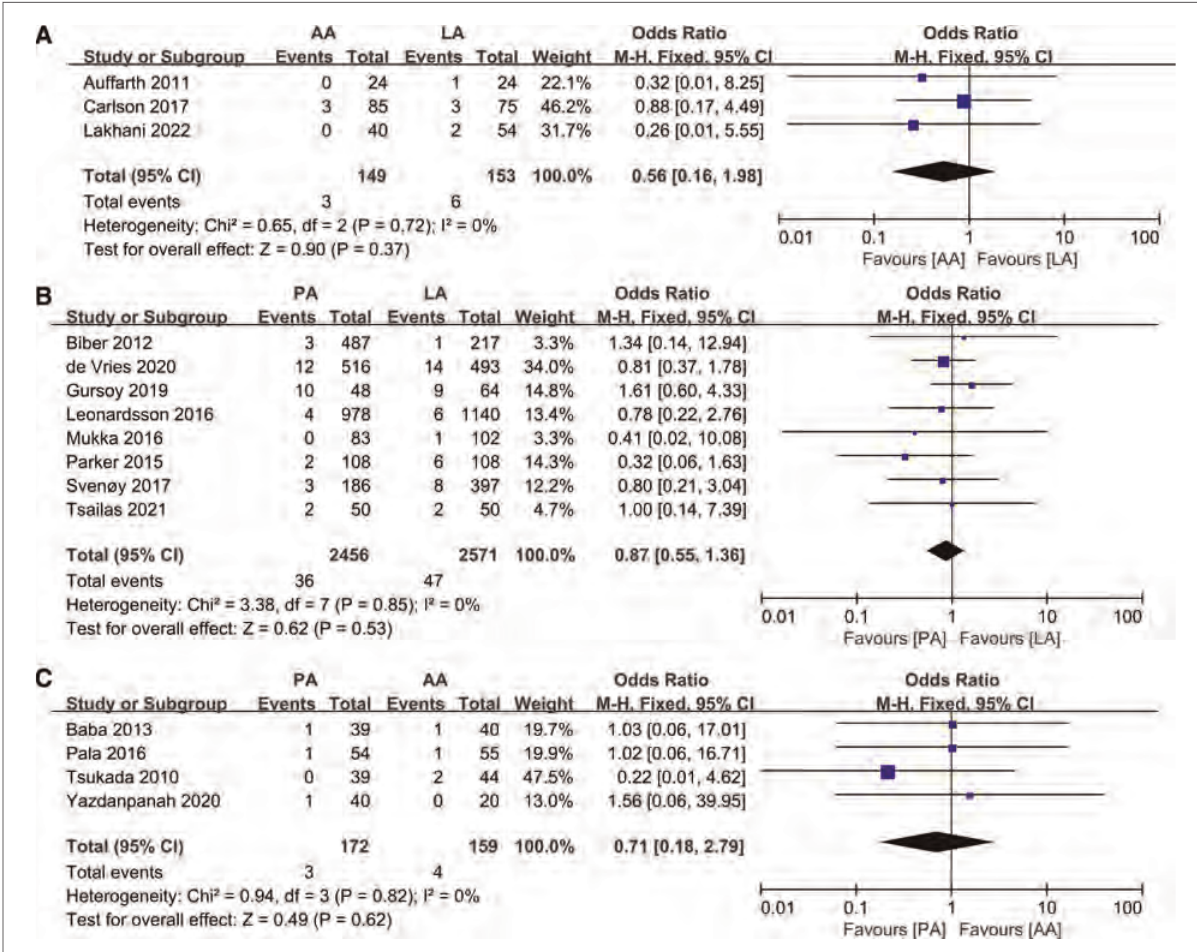
FIGURE 8 Forest plot comparison of fractures. ( A ) Anterior approach and lateral approach, ( B ) Posterior approach and lateral approach, ( C ) Posterior approach and anterior